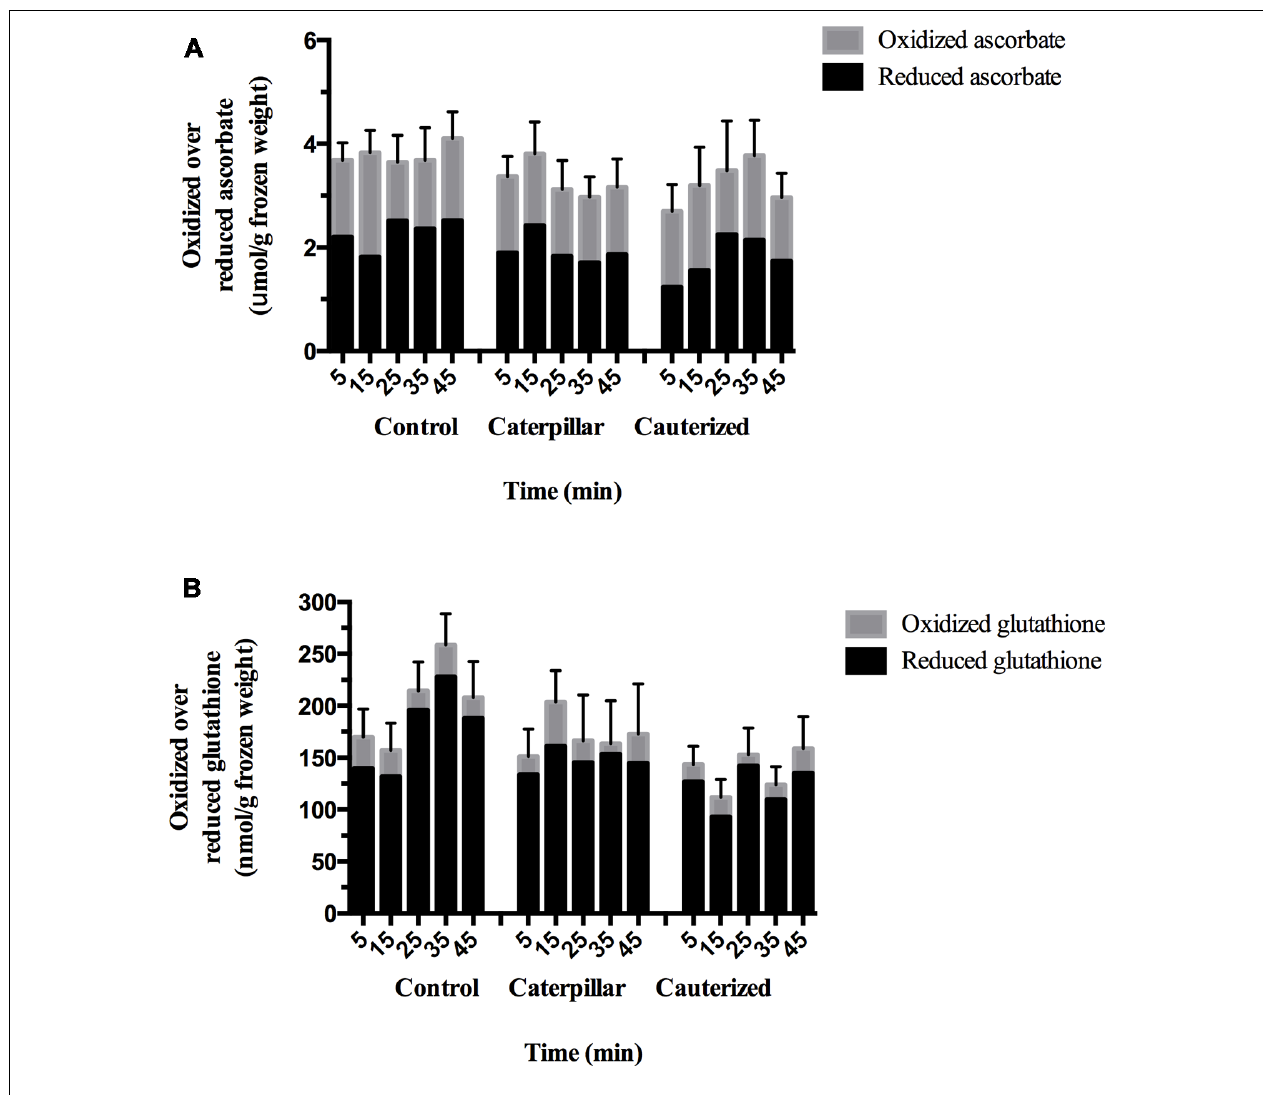
caterpillars with normal (caterpillar) or impaired salivary secretions (cauterized) compared to control plants. Solid bars represent reduced glutathione (GSH) levels. Open bars represent oxidized glutathione (GSSG) levels.Values are given in nmol/g FW and represent means ± SE of three to four